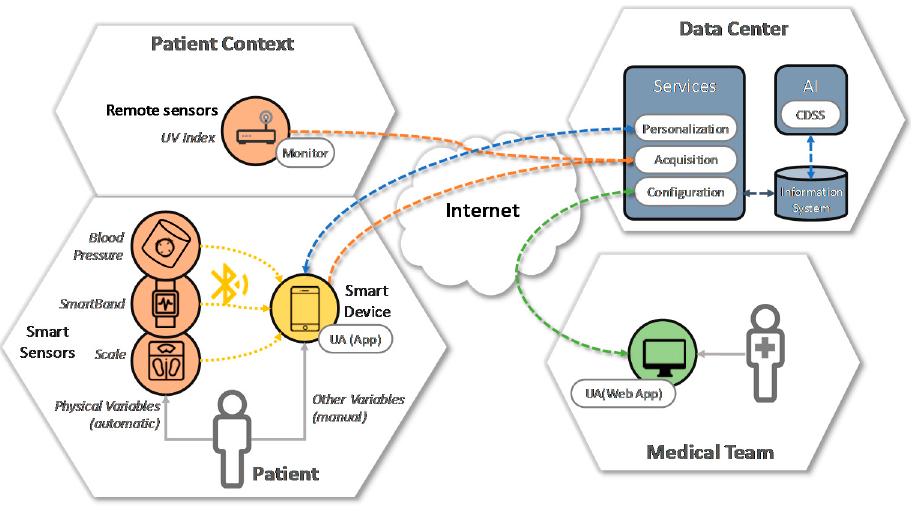
Figure 4. System architecture for Crohn´s disease management.